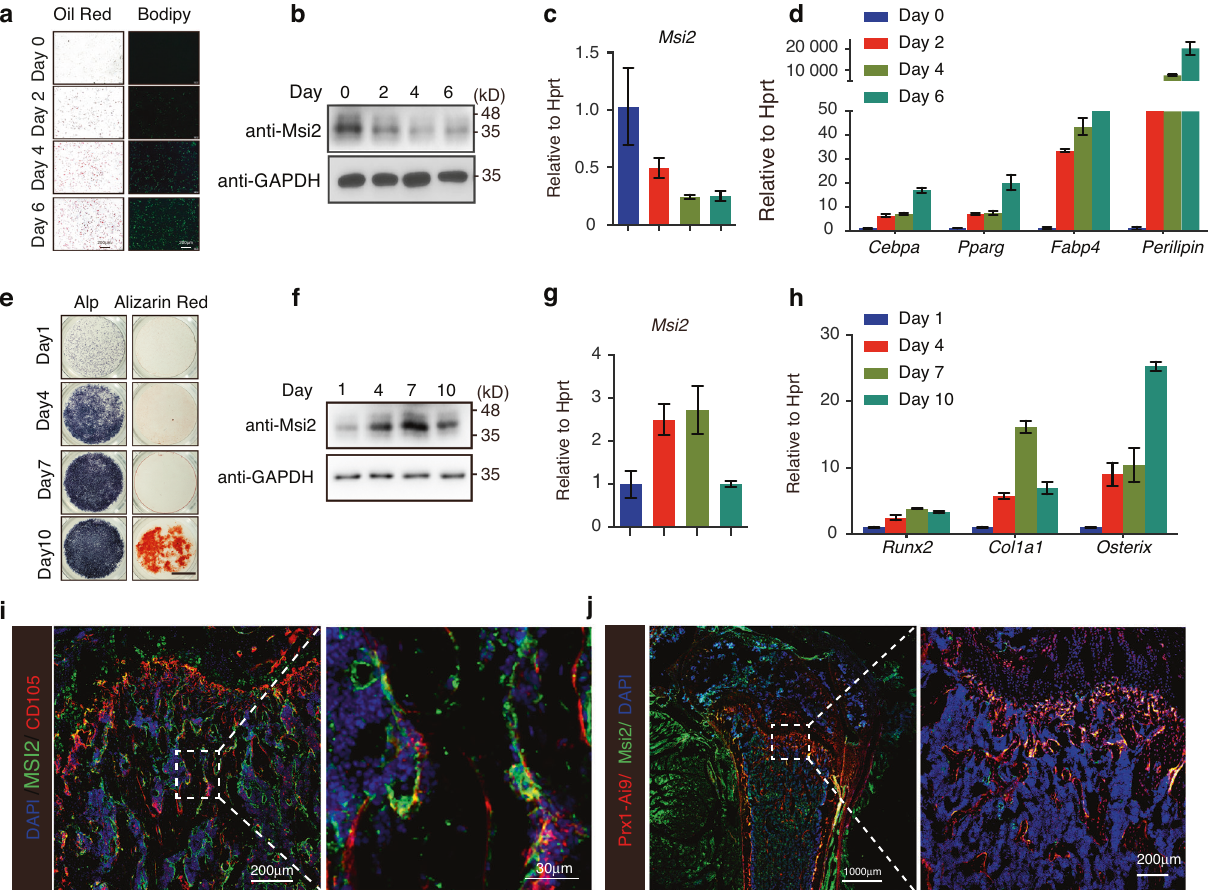
Fig. 1 Changes in Msi2 expression levels in the adipogenesis and osteogenesis of BMSCs. a BMSCs isolated from 4-week-old wild-type mice. Cultures were stained with Oil Red O and BODIPY as shown. Scale bar = 200 μ m. b Western blot analysis of Msi2 levels during adipogenesis for different durations. c qPCR analysis of Msi2 expression in BMSCs during adipogenesis for the indicated durations. Data represent the mean ± SD, n = 4. d qPCR analysis of the expression of adipocyte markers, including perilipin, Fabp4, Ppar γ and Cebp α , in BMSCs during adipogenesis for the indicated durations. Data represent the mean ± SD, n = 4. e BMSCs isolated from 6-week-old wild-type mice. Cultures were stained with ALP and Alizarin red S as shown. Scale bar = 3 mm. f Western blot analysis of Msi2 levels during osteogenesis for different durations. g qPCR analysis of Msi2 expression in BMSCs during osteogenesis for the indicated durations. Data represent the mean ± SD, n = 4. h qPCR analysis of the expression of osteoblast markers, including Runx2 , Col1a1 and Osterix , in BMSCs during osteogenesis for the indicated durations. Data represent the mean ± SD, n = 4. i Immunostaining of Msi2 (green), CD105 (red) and DAPI (blue) in tibia from 6-week-old WT mice. Scale bar = 200 μ m (left). Scale bar = 30 μ m (right). j Immunostaining of Msi2 (green) and DAPI (blue) in femurs from 6-week-old Prx1-Cre Tdtomato mice. Scale bar = 1 000 μ m (left). Scale bar = 200 μ m